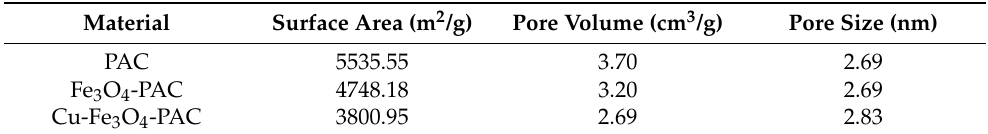
Table 1. Structural and textural characteristics of carbon materials calculated from dinitrogen sorption isotherms.